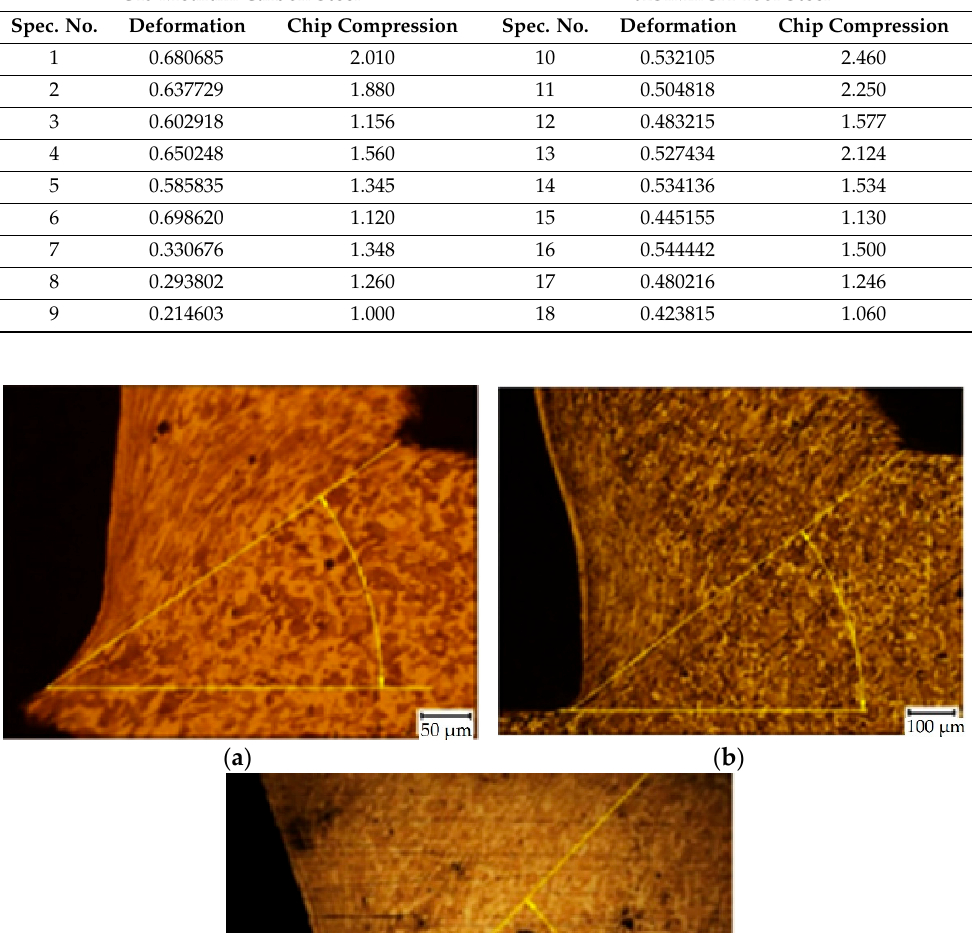
Table 4. Cutting parameters used in the experiment.